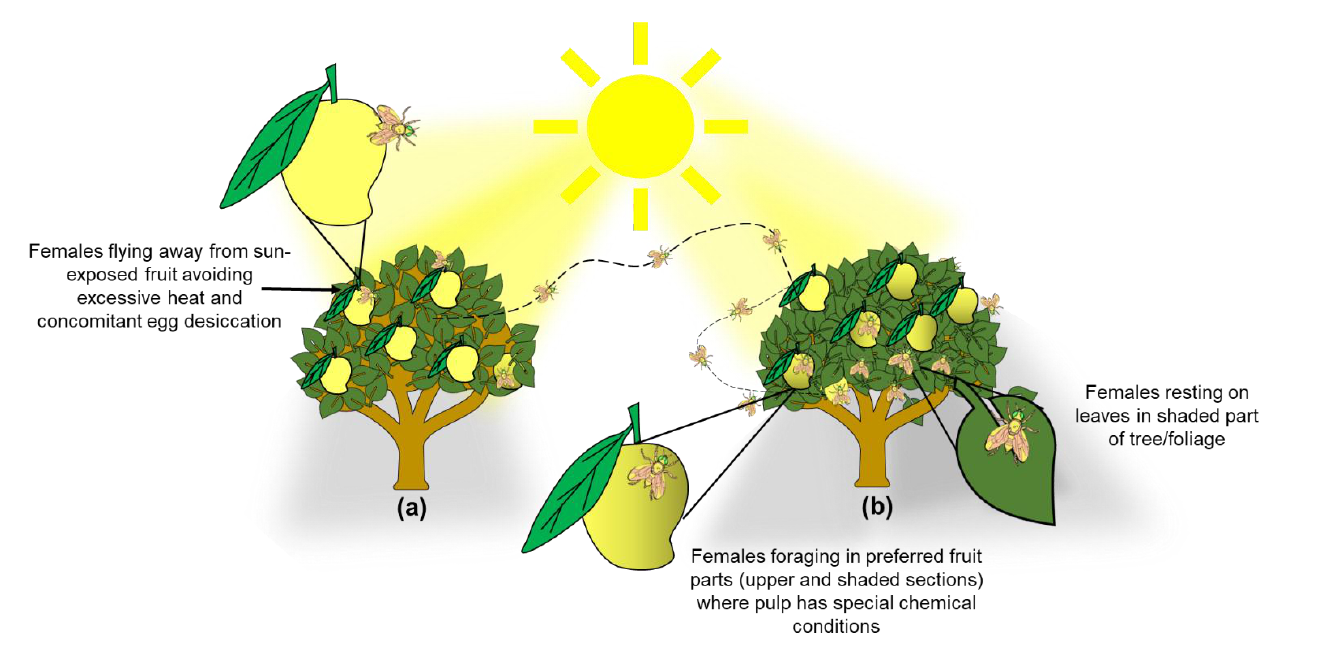
Figure 6. Graphical depiction of trees exhibiting two conditions to illustrate the management scheme proposed based on our findings and on Aluja et al. [104]. ( a ) Pruned tree with fewer branches/foliage to enhance sunlight incidence in the inner parts of the canopy to promote desiccation of A. obliqua eggs in the peel of mango fruit and force females to seek out trees with more foliage and benign environmental conditions; ( b ) Tree with excessive branching/foliage which generates ideal conditions for A. obliqua female foraging and egg laying (fruit infestation) (details at the end of Discussion).